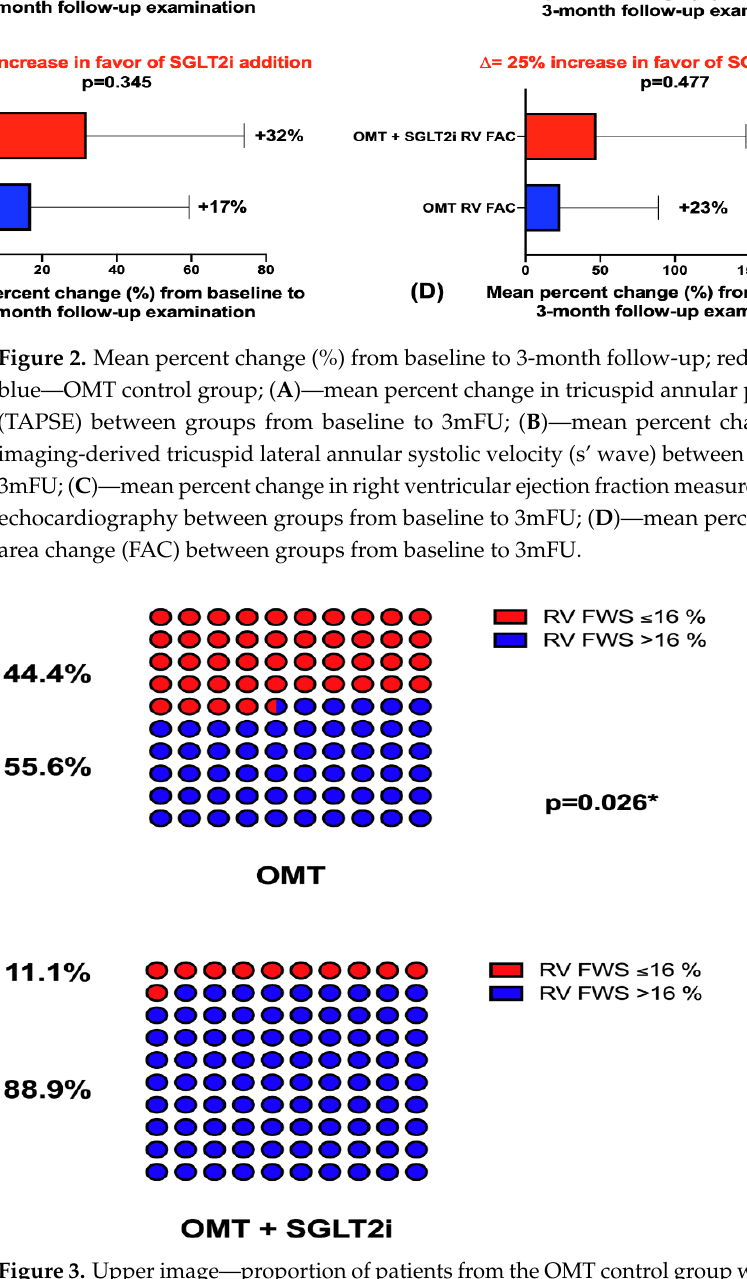
Figure 3. Upper image—proportion of patients from the OMT control group with the right ventricular free wall strain value (RV FWS) of − 16% or more positive to absolute zero value (red color); or above − 16% and more negative value from absolute zero value. Bottom image—proportion of patients from the OMT+ SGLT2i+ group with the right ventricular free wall strain value (RV FWS) of − 16% or more positive to absolute zero (red color); or over − 16% and more negative value from absolute zero.